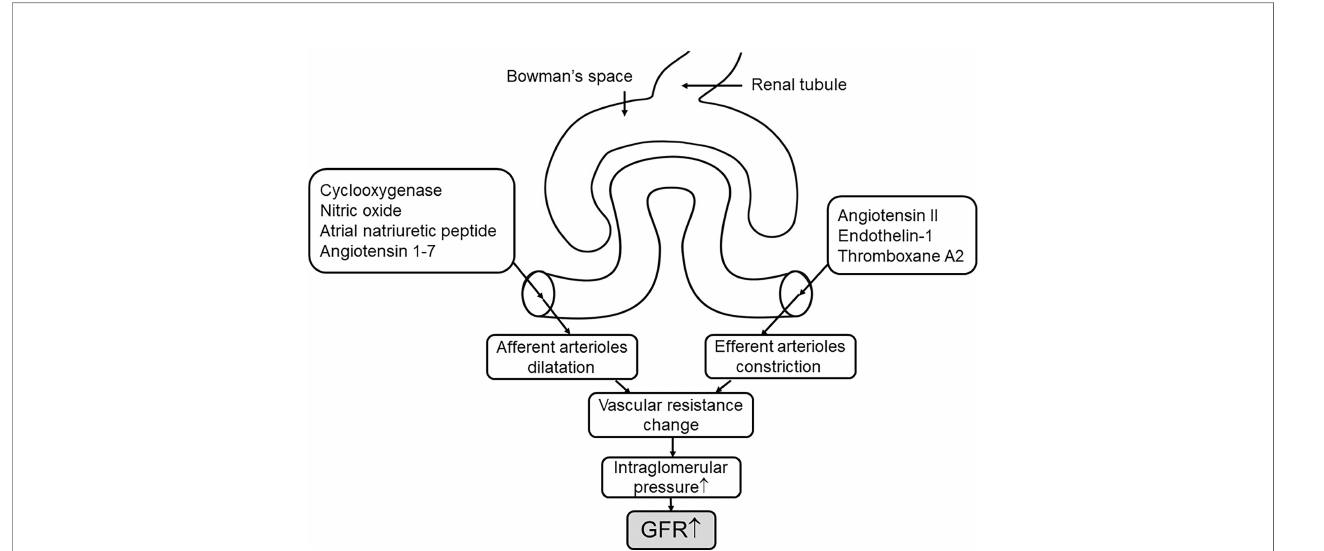
FIGURE 3 | The mechanisms of the vascular events on hyper fi ltration. The concentration of hormones and vasoactive mediators that mediate afferent arteriole dilation and efferent arteriole constriction increase in response to hyperglycemia (7) through altering the vascular resistance to elevate the pressure of intraglomerular, thus leading to increased GFR. ↑ , elevate or